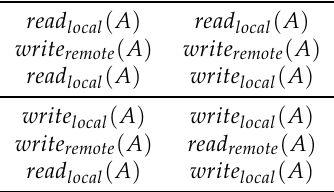
Table 1. Scenarios of the atomicity violation. Source